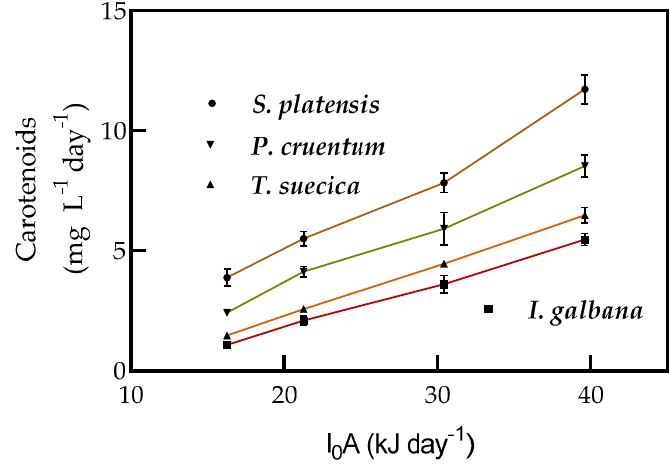
Figure 7. Carotenoids productivity of S. platensis , I. galbana , T. suecica , and P. cruentum in continuous culture under supplied light intensities of 16.27, 21.26, 30.42, and 39.63 kJ d − 1 . Each point indicates the mean of 3 replicates ( p < 0.05).